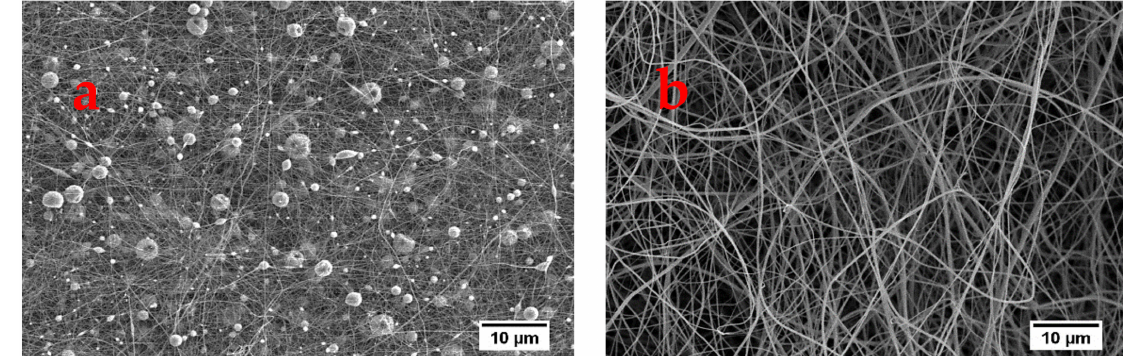
Figure 5. SEM images of electrospun nanofibers of Ca(NO 3 ) 2 films using polymer concentrations of ( a ) 8 and ( b ) 10 wt%.